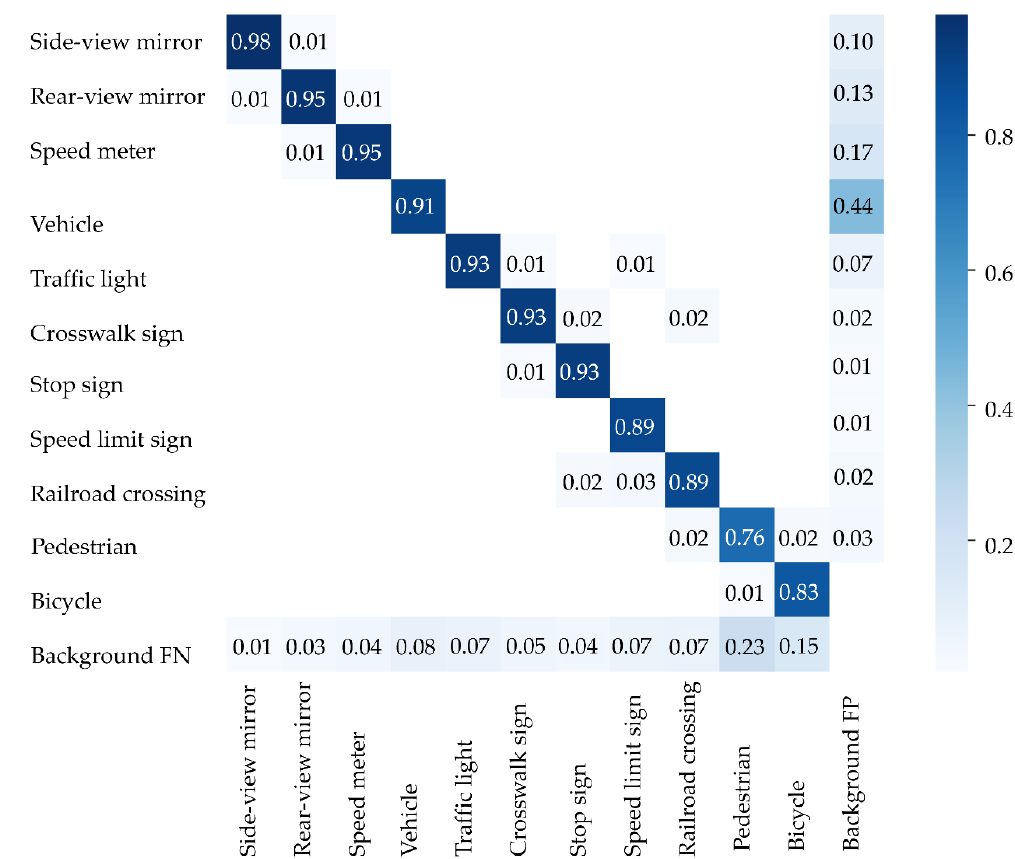
Figure 3. The result of object detection is shown by a confusion matrix.